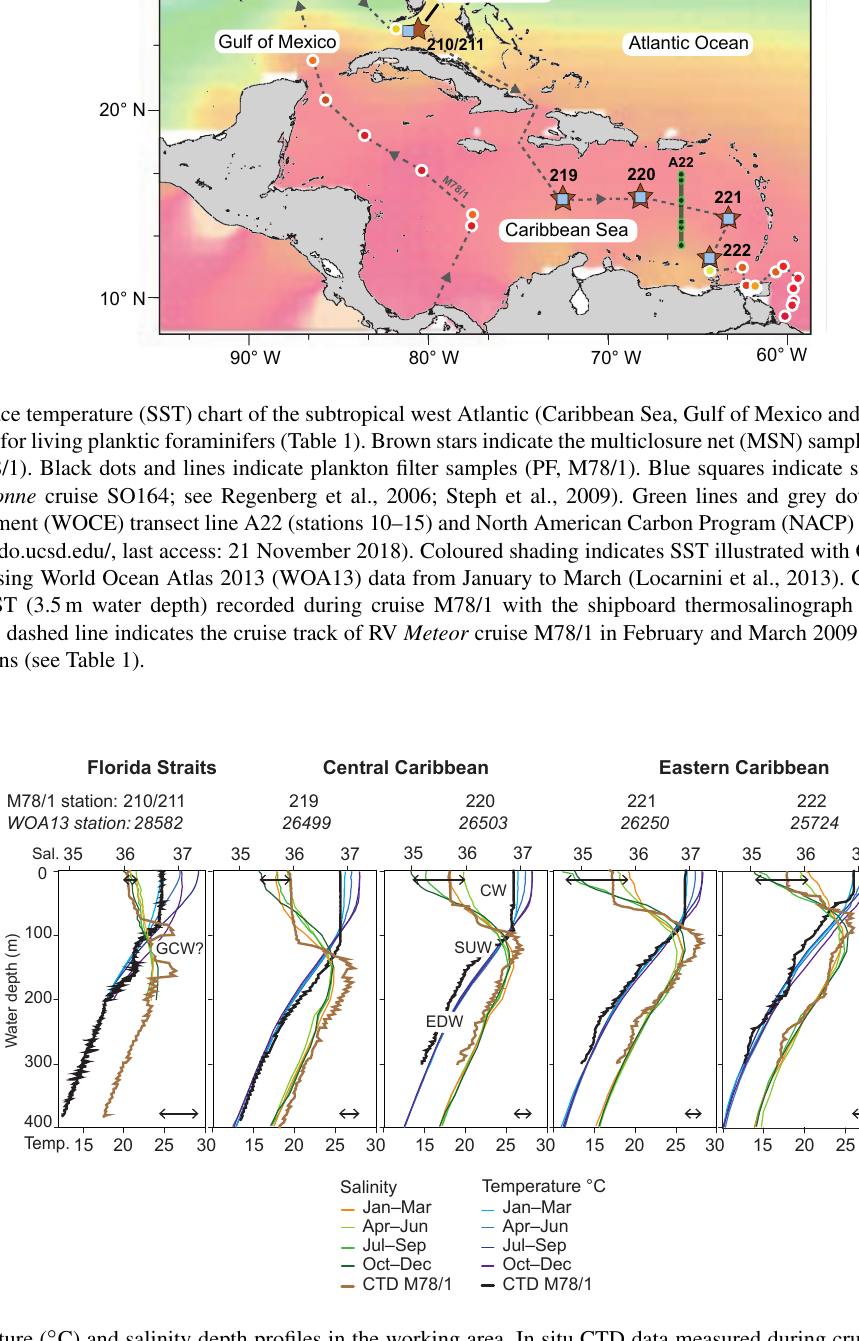
Figure 2. Temperature ( ◦ C) and salinity depth profiles in the working area. In situ CTD data measured during cruise M78/1 (March 2009, thick brown and black lines) are presented in comparison to the seasonally differentiated World Ocean Atlas 2013 (WOA13) data (Locarnini et al., 2013; Zweng et al., 2013; coloured thin lines). GCW is Gulf Common Water; CW is Caribbean water; SUW is Subtropical Underwater; EDW is 18 ◦ C Sargasso Sea water. Black double arrows indicate the seasonal ranges of temperature (bottom) and salinity (top) in the uppermost water column (0–10m water